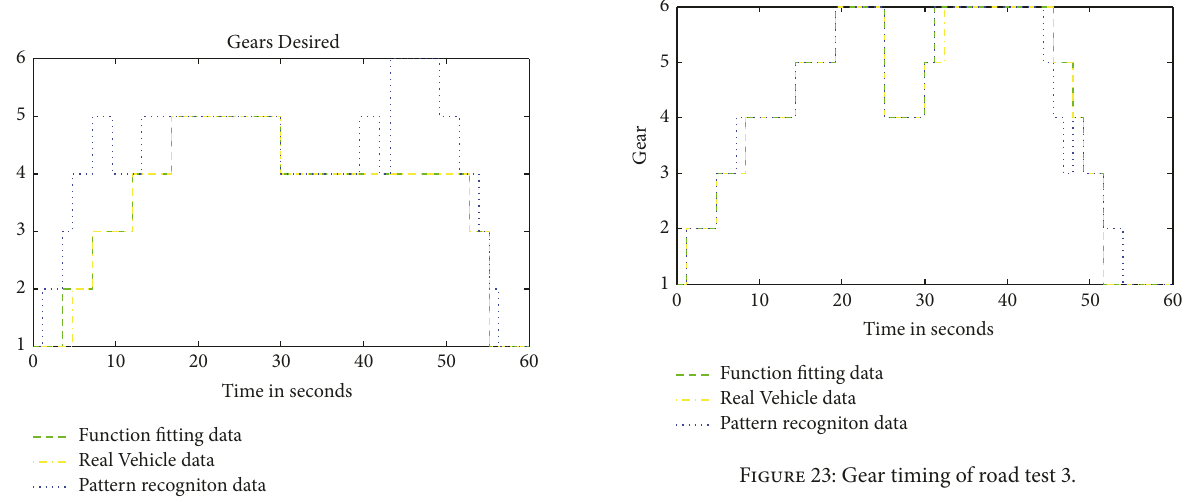
Figure 20: Accuracy of neural network classification.